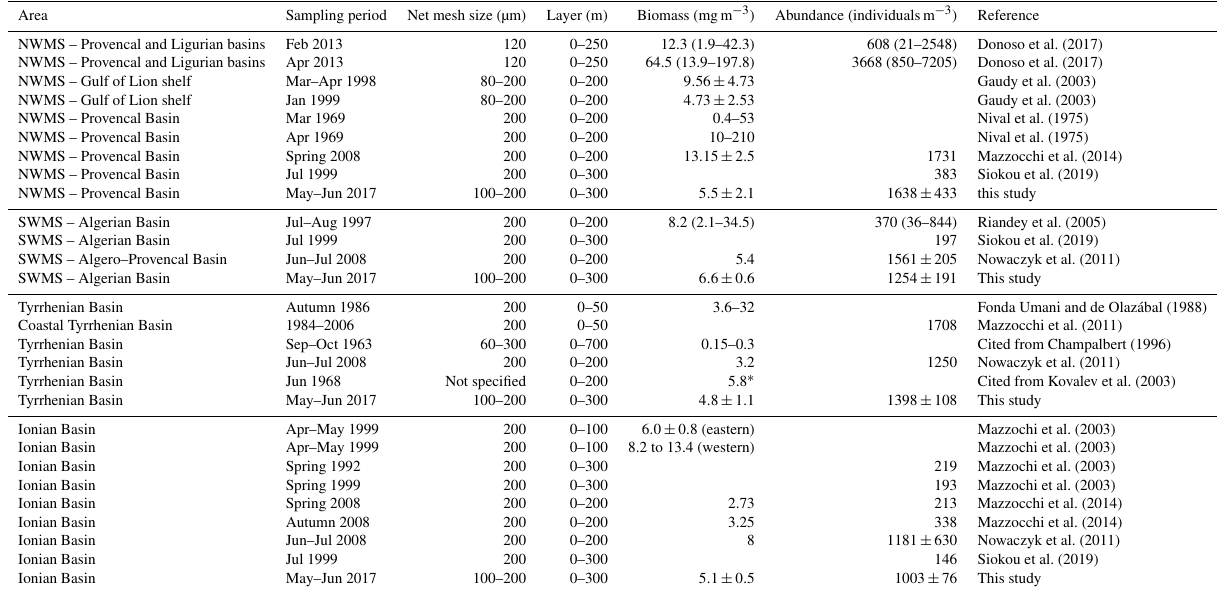
Table 7. Comparison of zooplankton biomass and abundance in different areas of the Mediterranean Sea. “ ∗ ” denotes the wet weight. NWMS refers to the northwestern Mediterranean Sea, and SWMS refers to the southwestern Mediterranean